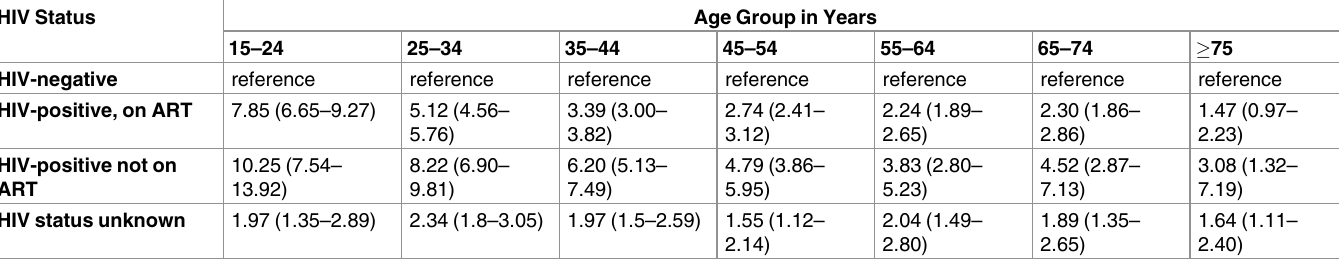
Table 3. Adjusted hazard ratios for the association between HIV/ART status and death, stratified by age group, among patients with smear-posi- tive pulmonary disease. HIV